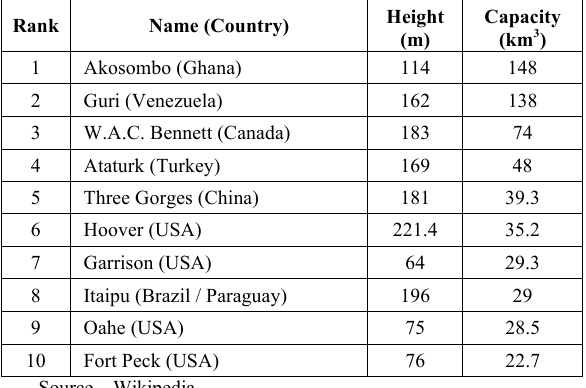
TABLE II. T EN L ARGEST D AM R ESERVOIRS